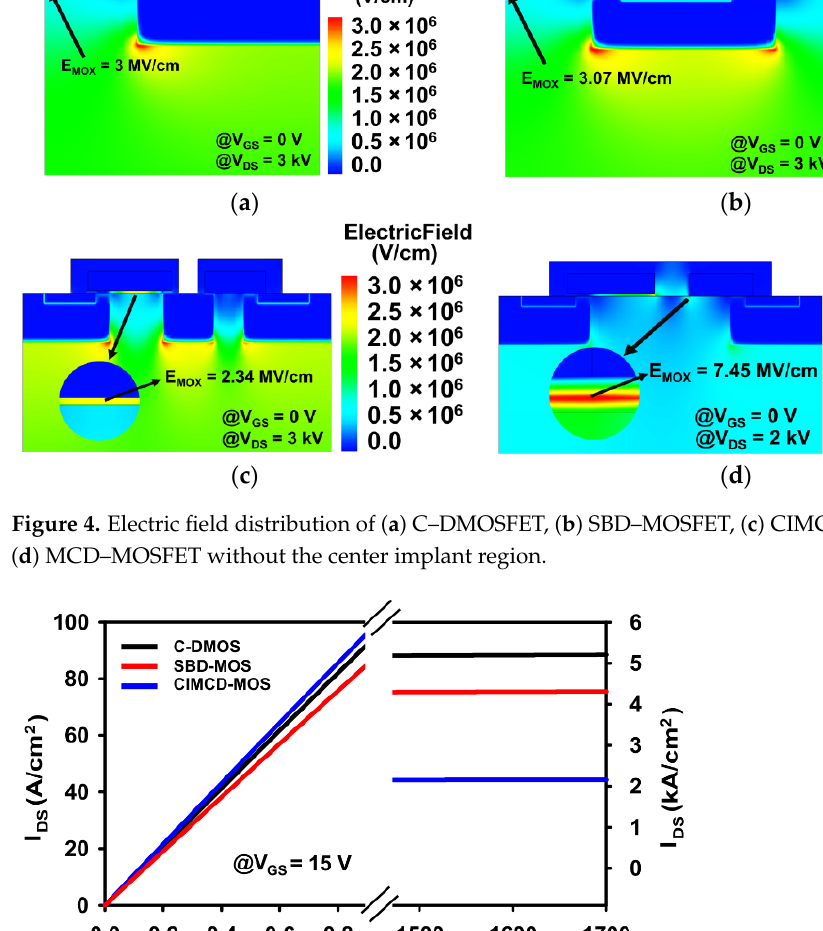
( a ) ( b ) Figure 6. ( a ) Third quadrants characteristics of C – DMOSFET, SBD – MOSFET, and CIMCD – MOSFET. ( b ) Variation of diode turn-on voltage (V F ) and oxide edge maximum electric field of CIMCD-MOSFET with Tox 2 . Table 2. Static characteristics of devices.